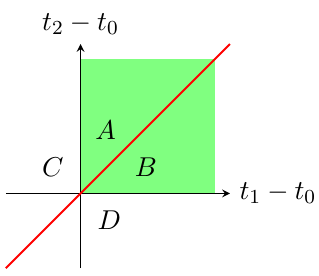
Figure 4. Regions for the retarded solution of equation (B.6). The function W ( t 1 , t 2 ) has a jump discontinuity at the boundary of the green-colored quadrant. In addition, the normal derivative is discontinuous at the red diagonal